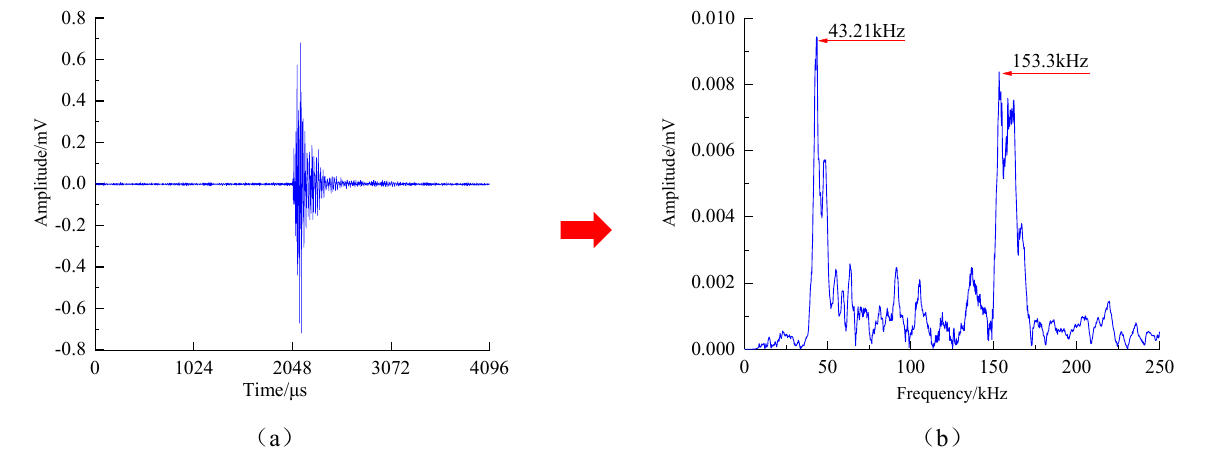
Figure 5. Waveform time–domain and frequency–domain diagram (( a ) original waveform diagram and ( b ) amplitude–frequency diagram).